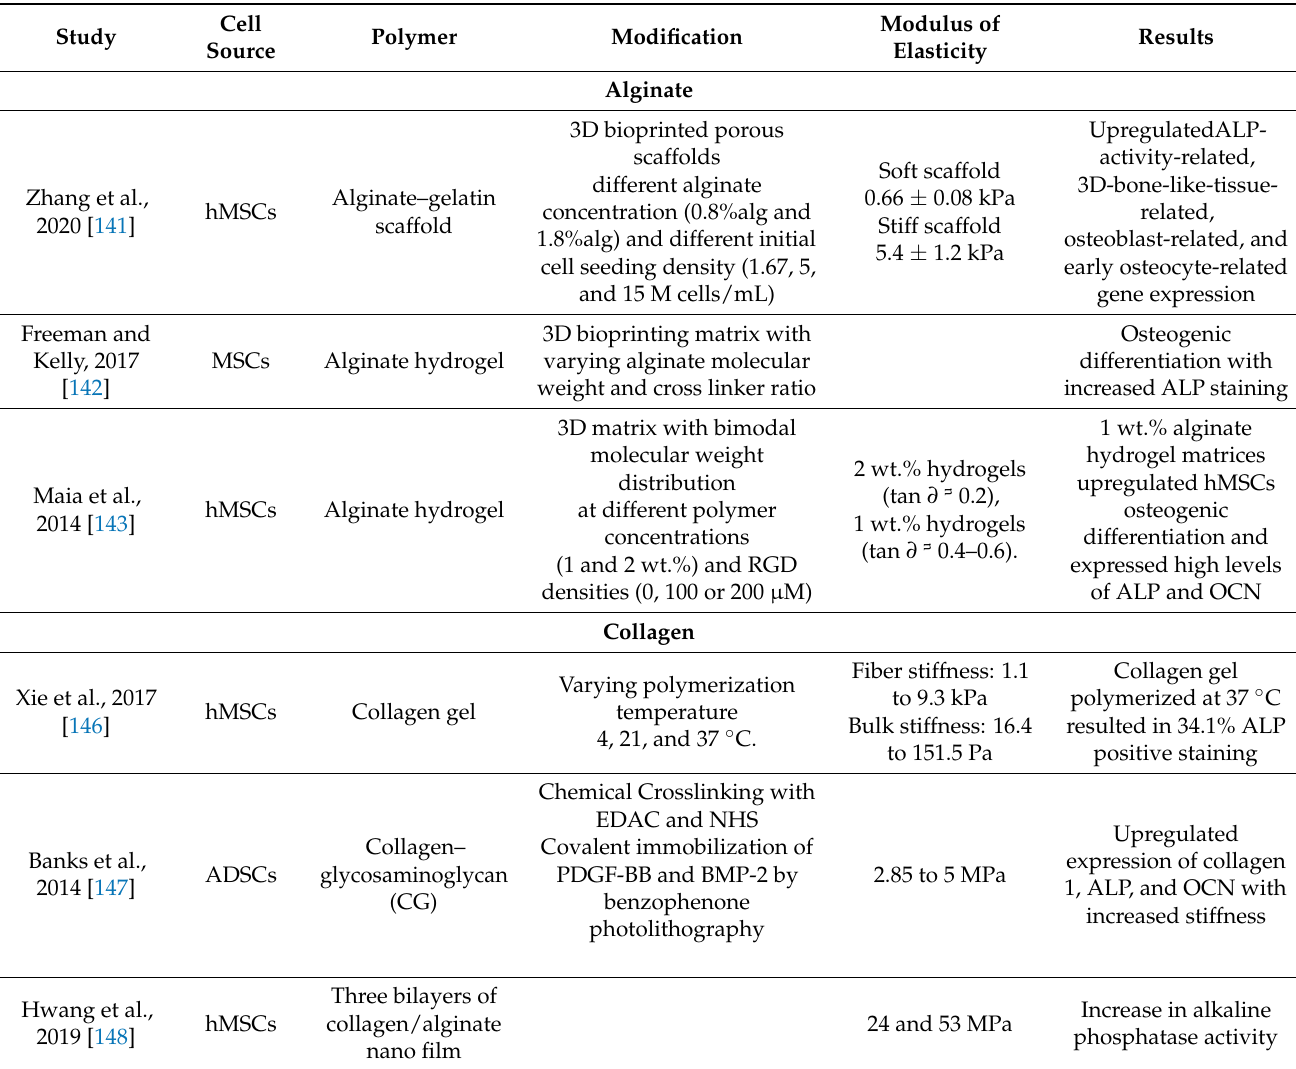
Table A1. Key studies on the effect of polymeric matrix stiffness on osteogenic differentiation of mesenchymal stem/progenitor cells. Study